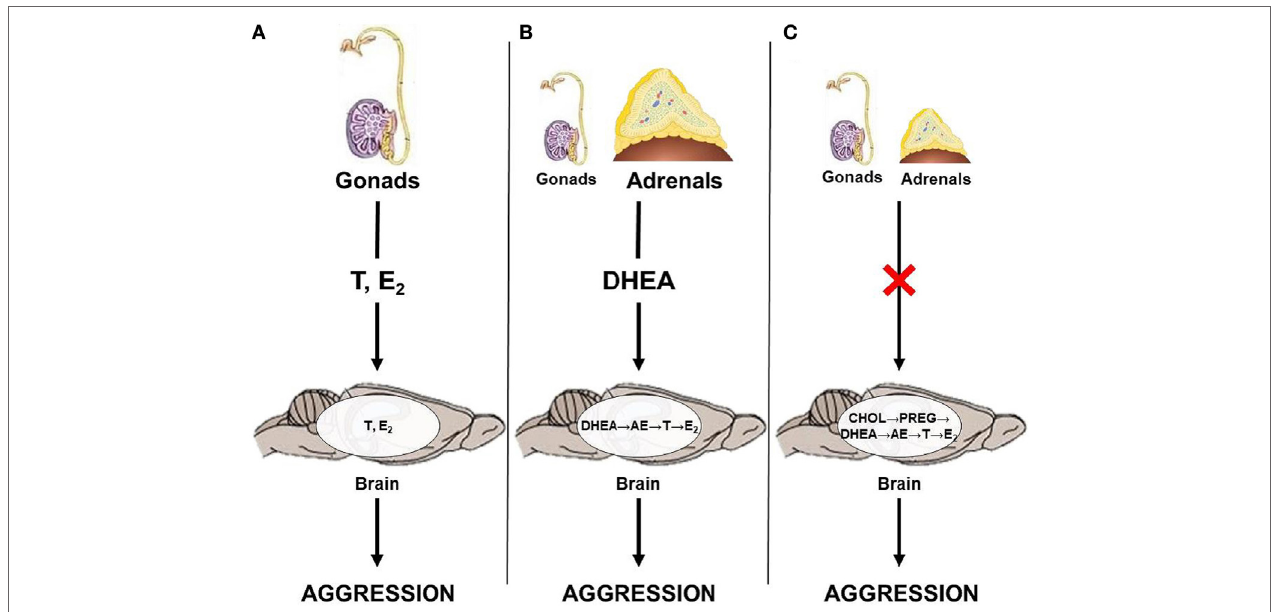
FiGURe 1 | Neuroendocrine pathways by which androgens could affect territorial aggression in seasonally breeding animals. (A) Gonadal steroids, such as testosterone (T) and estradiol (E 2 ), act directly on the brain; (B) adrenal dehydroepiandrosterone (DHEA) is locally converted to T and/or E 2 ; and (C) steroids are produced de novo in the brain from cholesterol (CHOL) via conversion to pregnenolone (PREG) and, subsequently, to DHEA, androstenedione (AE), T, and E 2 in the absence of steroid production from the gonads and adrenal